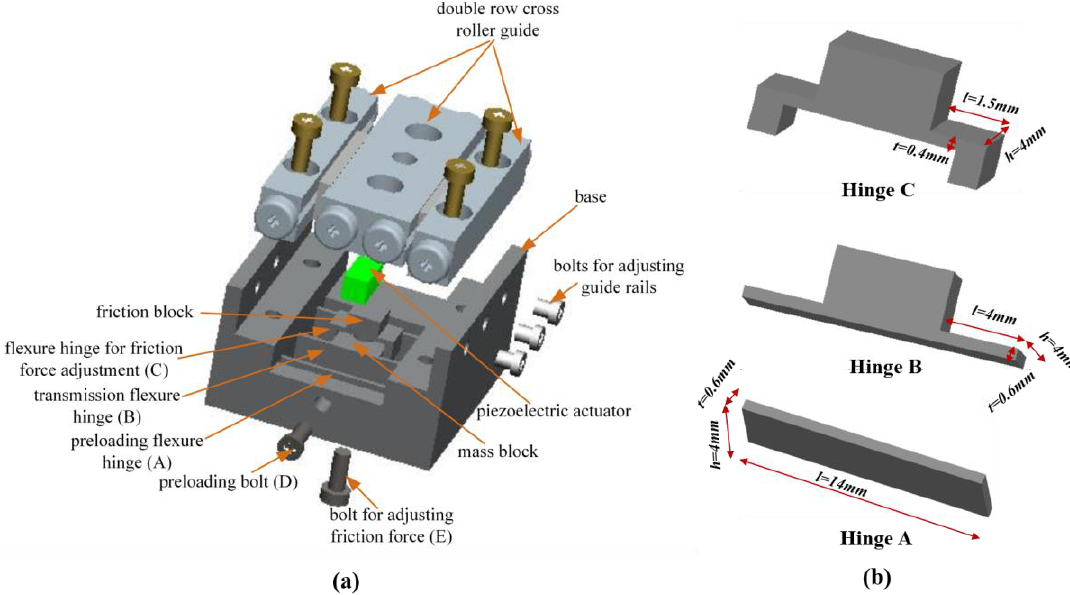
Figure 2. ( a ) Schematic of the developed stick-slip positioning stage; ( b ) zoom in on the different hinges (A, B,